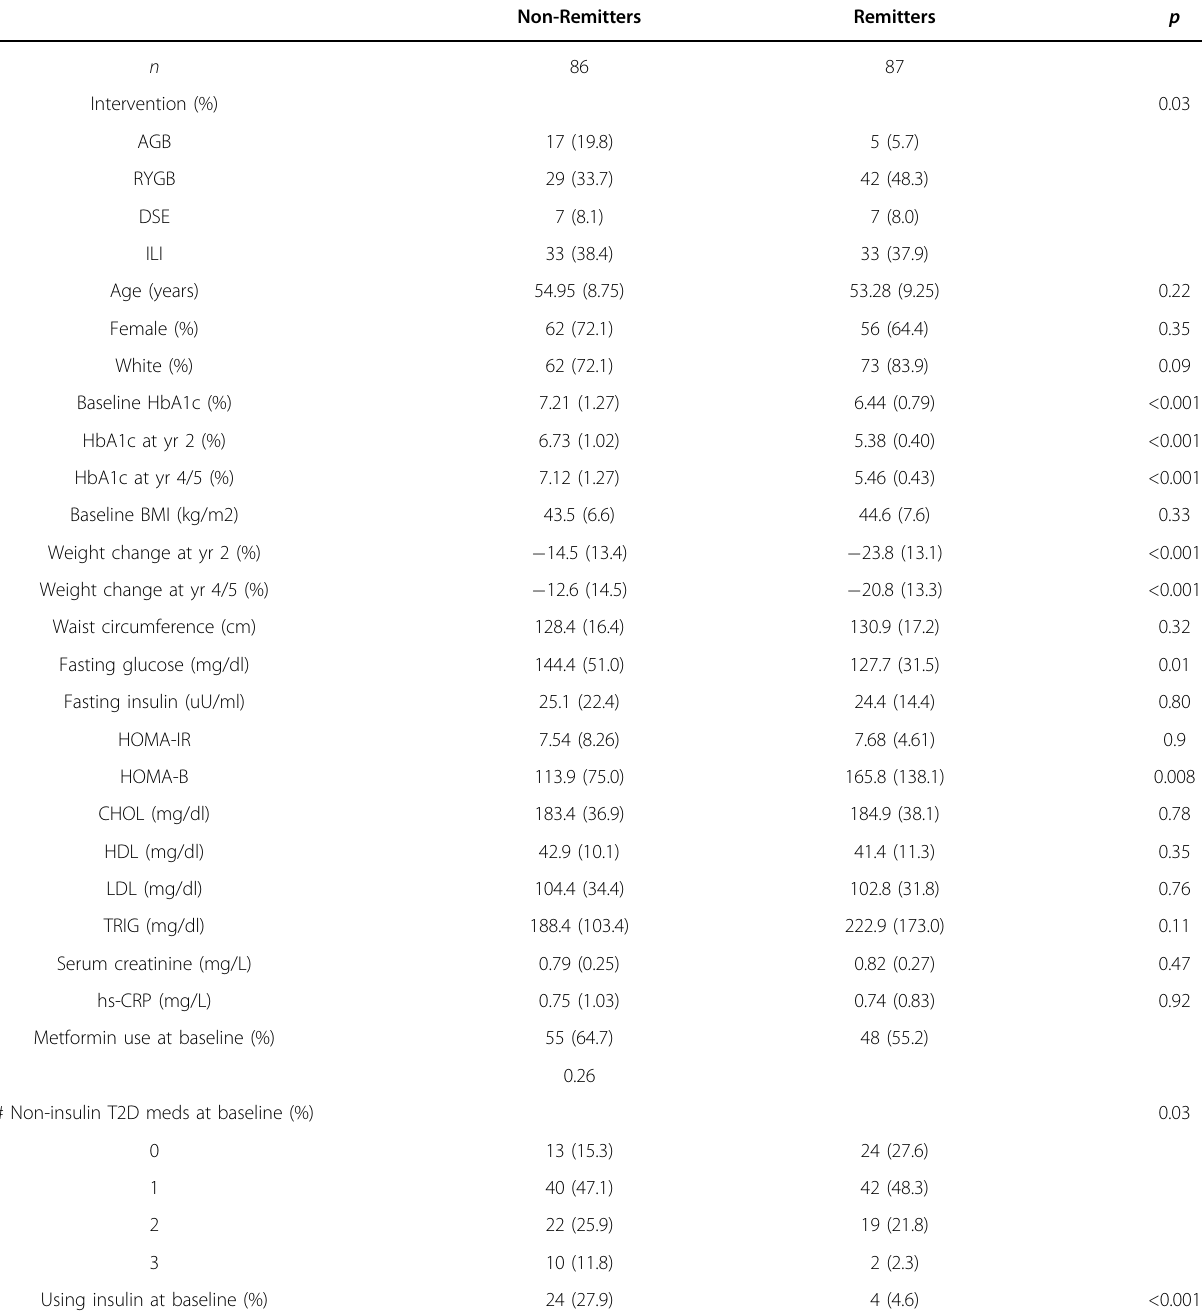
Table 1 Baseline demographics and clinical characteristics of individuals with and without type 2 diabetes remission, from LABS and LookAHEAD cohorts